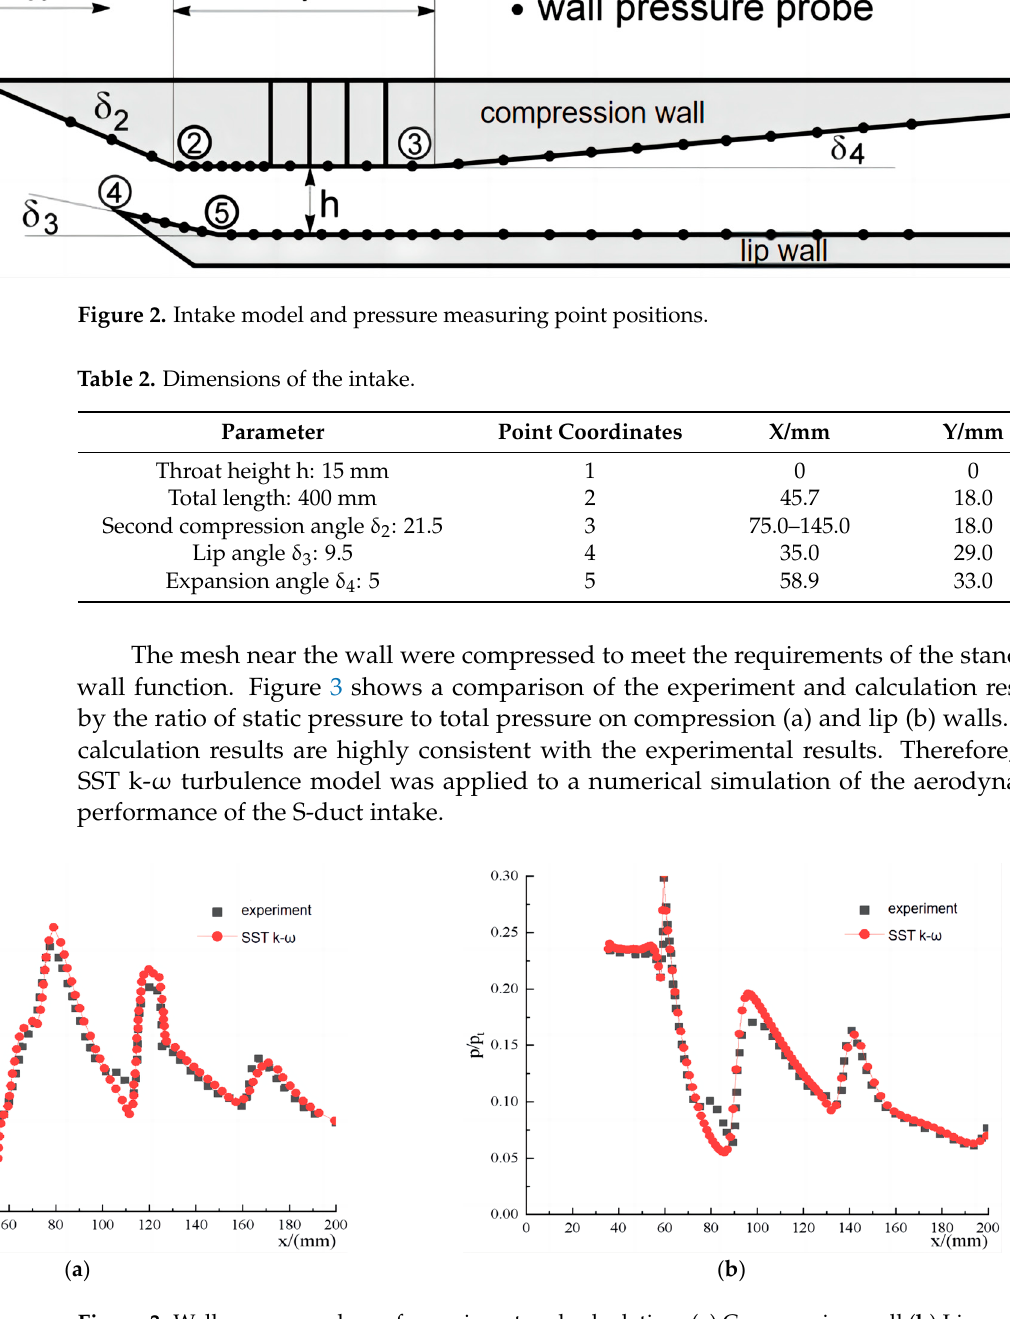
Figure 3. Wall pressure values of experiment and calculation. ( a ) Compression wall ( b ) Lip wall.